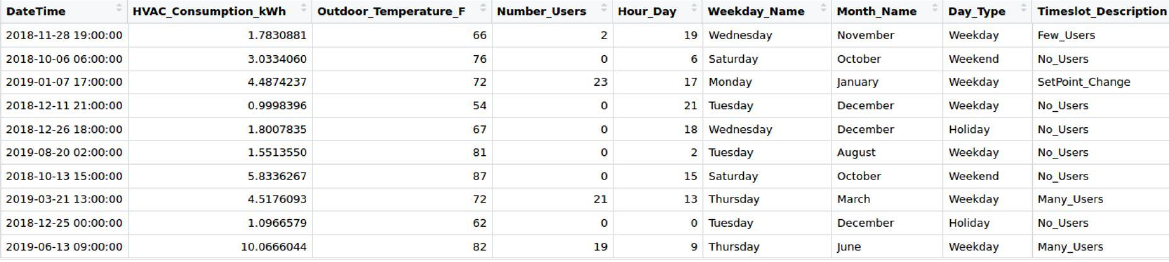
Table 2. A statistical summary of numerical features used in the analysis .